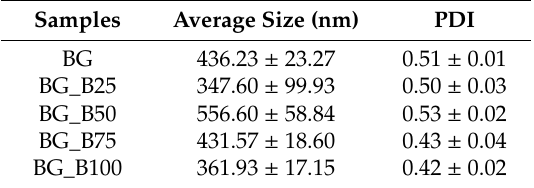
Table 1. The average sizes and polydispersity index (PDI) index values of BG and B-doped BG.